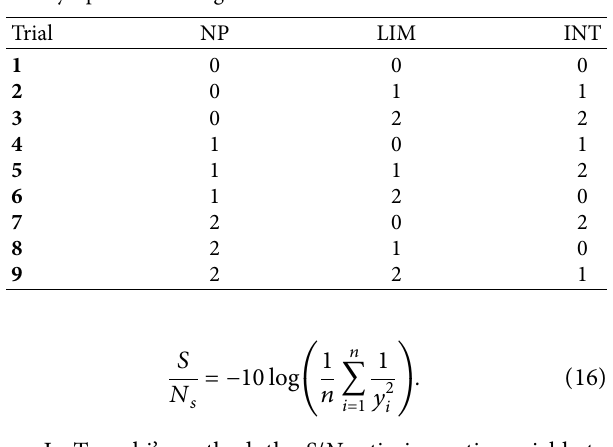
Table 6: Modified Taguchi L9 orthogonal array for artificial bee colony optimization